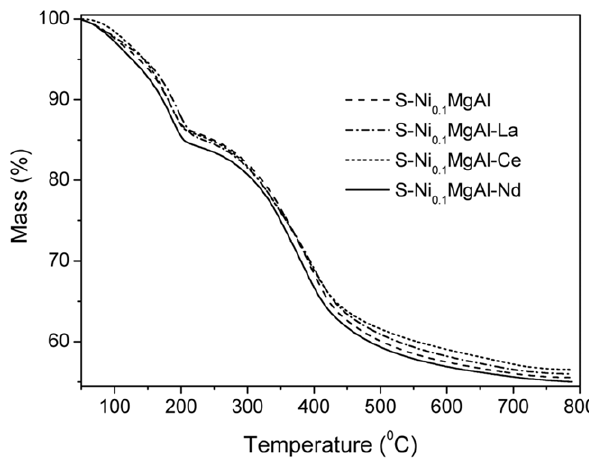
Figure 1. TGA curves of S-Ni 0.1 MgAl, S-Ni 0.1 MgAl-La, S- Ni